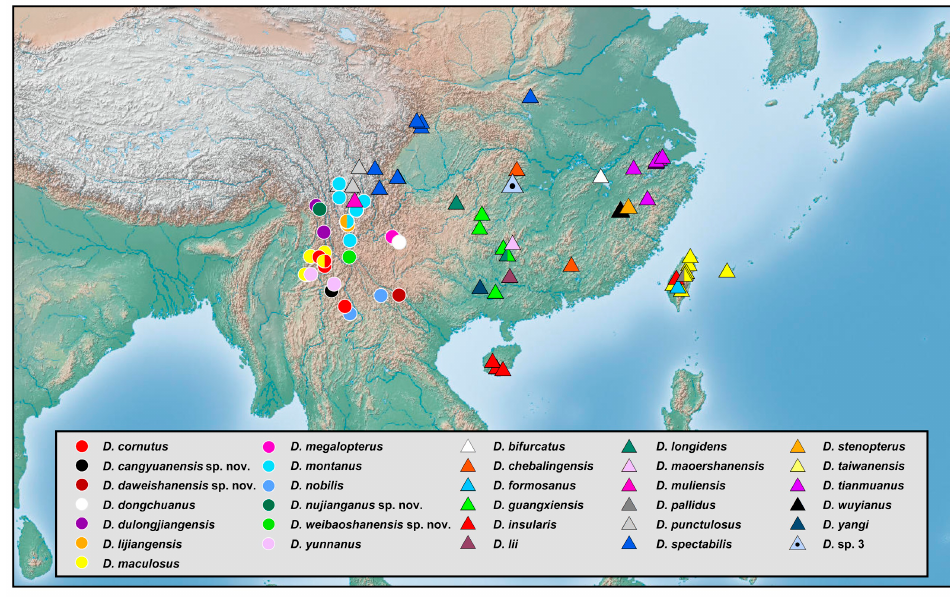
Figure 25. Distribution map of the species of Dilar from Oriental China (Region 6 in Figure 19). Southern Tibet and adjacent area (Region 4). The five species from this region account for 6% of global fauna (Figure 23). Adults occur from April to August in the elevation range of 939–3900 m. The distribution of all five species is not only concentrated, but also re- stricted, to the Himalayas. The species are assigned to the D. guangxiensis species-group [26], which further includes species from southern China, indicating a close relationship between those from the Himalayas and southern